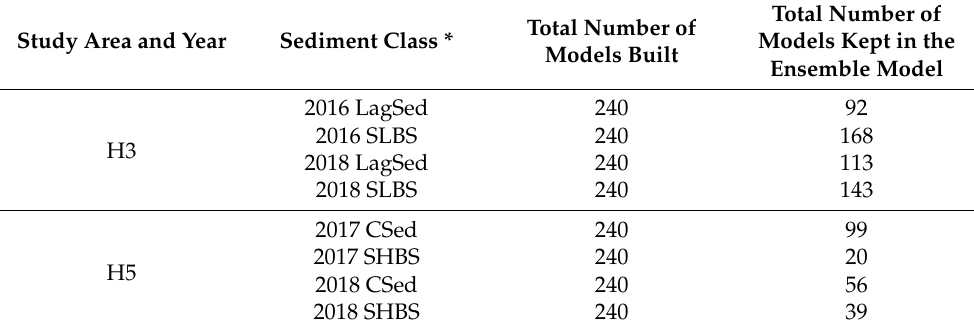
Table 4. Summary of the total numbers of models that were built for each study area and sediment class, and the number of models that were kept in the final ensemble